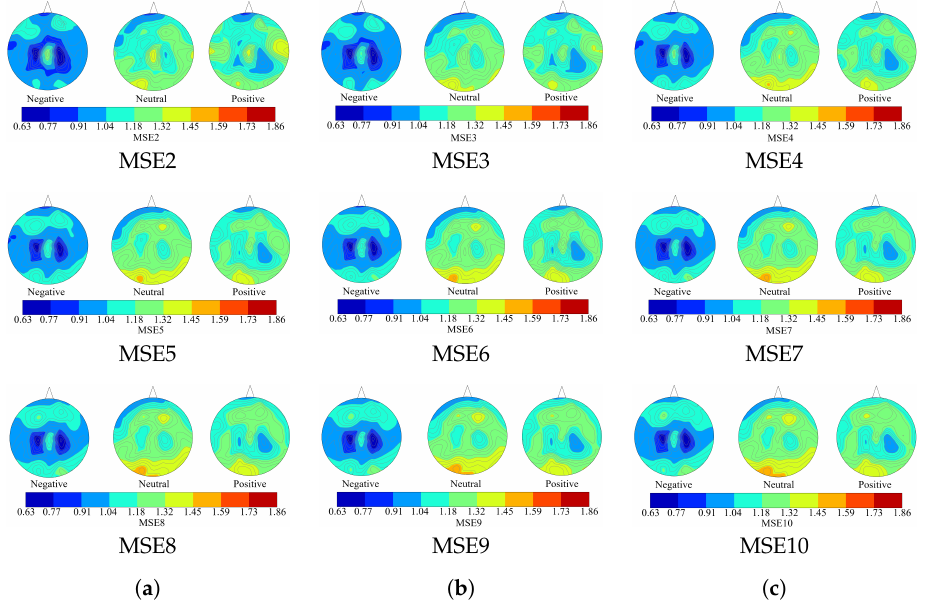
Figure A12. Grand averages of spatial maps of participants’ MSE2s (i.e., 62 MSE2s associated with 62 EEG channels of a participant, per affect) through MSE10s (i.e., 62 MSE10s associated with 62 EEG channels of a participant, per affect). Distribution of MSEs in these spatial maps corresponds to the EEG channels’ arrangement in Figure 1B in the main text (i.e., one MSE value, per EEG channel).